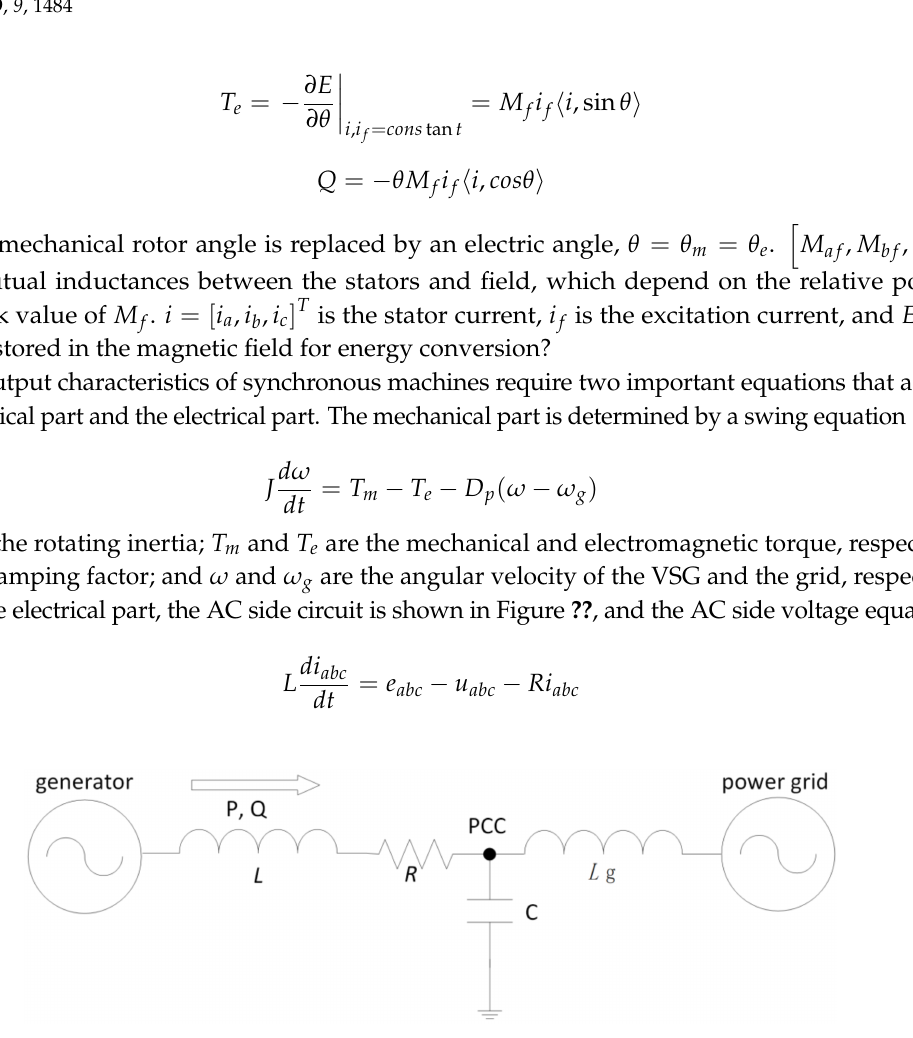
Figure 4. Alternating current (AC) side circuit of synchronous